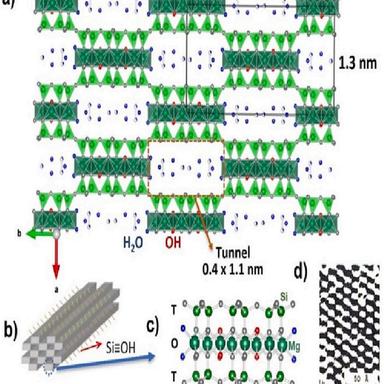
a) HR-TEM image of the cross-section of a sepiolite fiber showing the presence of structural tunnels and interfibrillar spaces between elemental fibers (modified image, reprinted from with permission from Elsevier); b) Schematic representation of the arrangements of microfibers components of a sepiolite bundle.